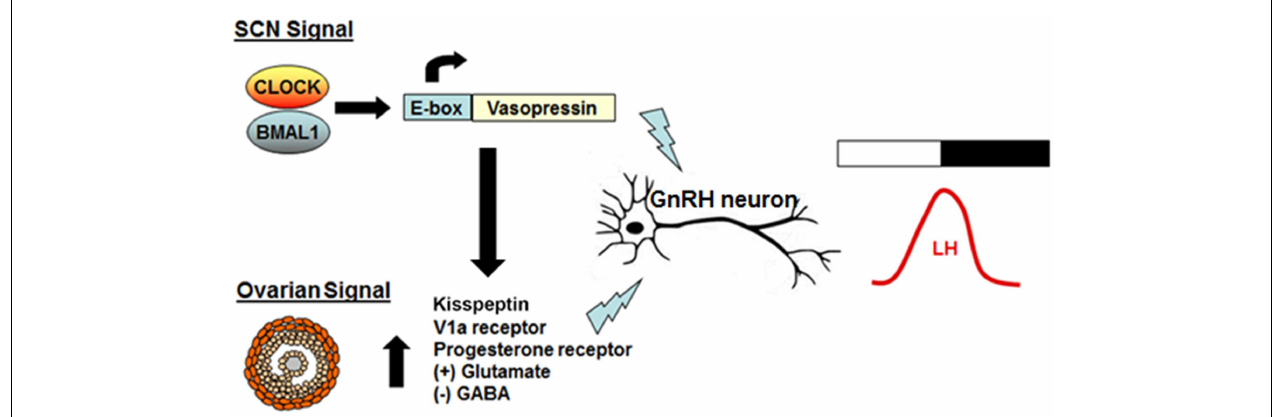
the ovary upregulates expression of hypothalamic AVP andVIP receptors and primes kisspeptin neurons to become more sensitive to the SCN-derived